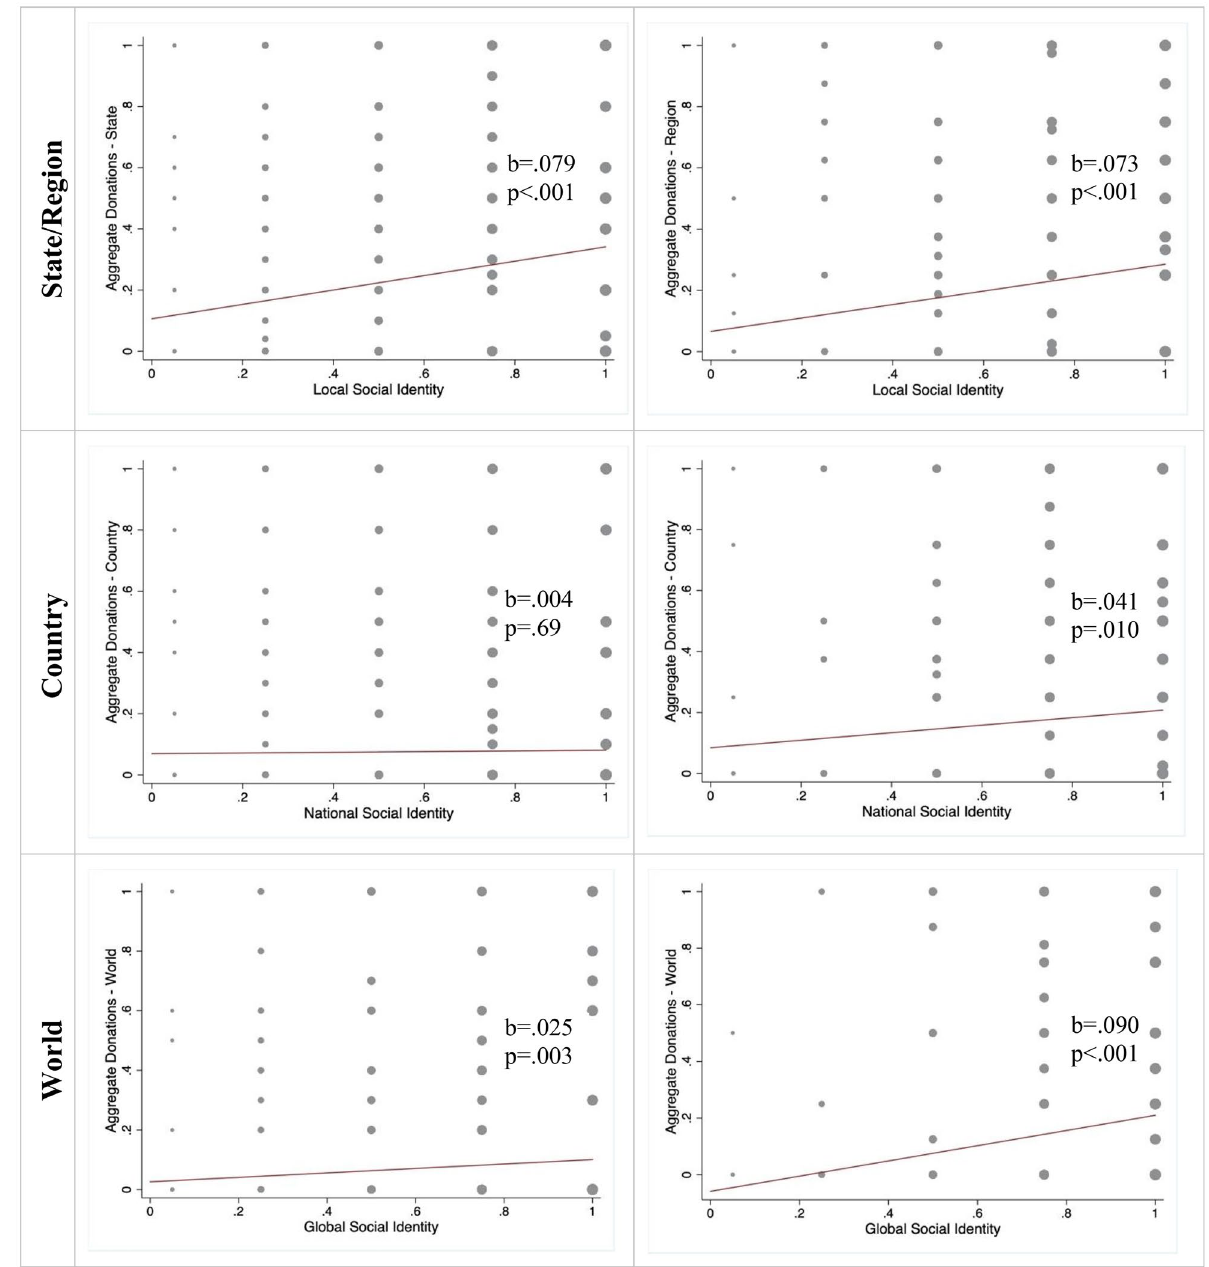
Figure 5. Relationship between social identity and corresponding level of aggregate donations. We plot the relationship between the three social identity scores (x-axis) and aggregate donations (y-axis). We grouped social identity scores on five, equally sized, bins. The size of the dots is determined by observed frequencies. The red lines are the OLS-best-fit interpolating lines. b is the slope of the interpolating line and p is the significance level of a t-test that the slope is equal to